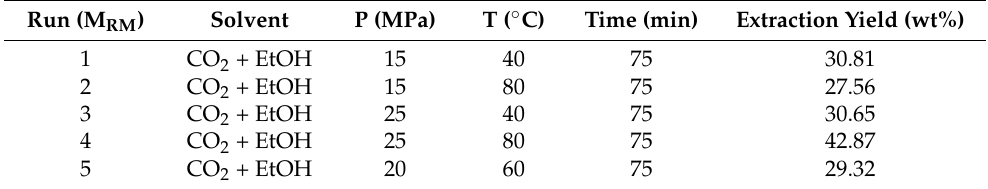
Table 2. Experimental conditions and extraction yield using scCO 2 + EtOH as a solvent considering dried fermented soybean raw material.